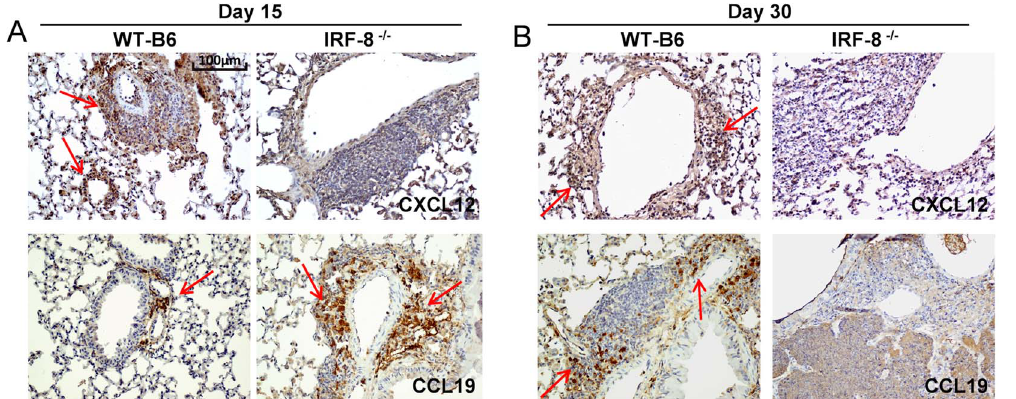
Figure 7. LS organization in lungs of Mtb -infected mice correlates with in situ chemokine expression. IHC analysis of peribronchial and interstitial areas of lung tissues from Mtb -infected IRF-8 2 / 2 and WT mice at day 15 (A) and day 30 p.i. (B) after staining with the indicated mAbs (brown) against CCL19 and CXCL12. Red arrows depict marker-positive cells. Representative slides are shown all taken at 200X magnification. Three independent experiments were performed.